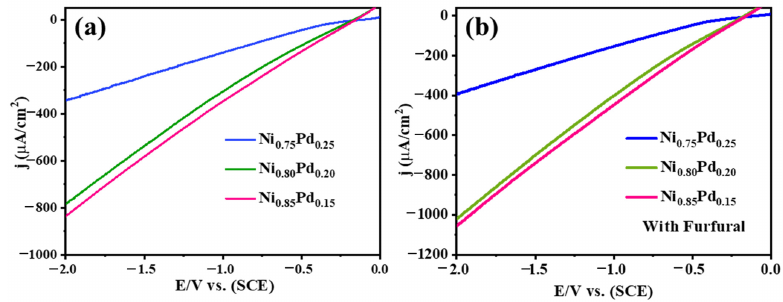
Figure 4. Linear sweep voltammetry (LSV) for Ni (1 − x) Pd x alloys with various molar ratios without furfural ( a ) and with furfural ( b ).